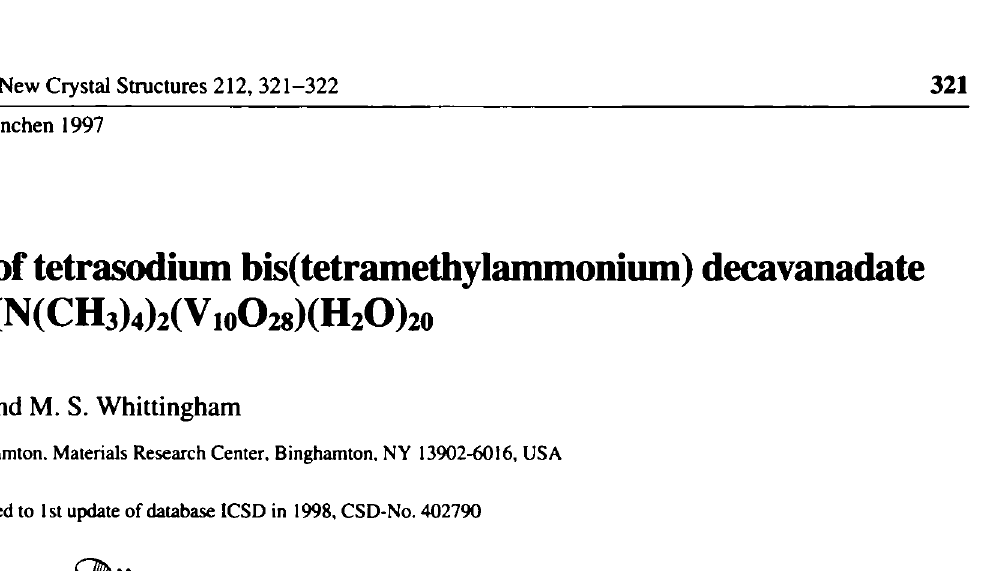
Fig. 1. V10H28 cluster.